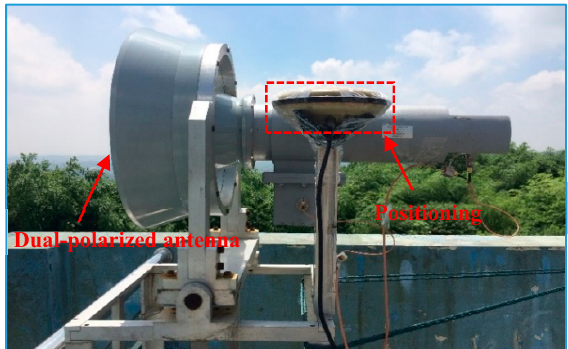
Figure 1. Outdoor antenna section of the Global Navigation Satellite System (GNSS) dual-polarized rain detection system.